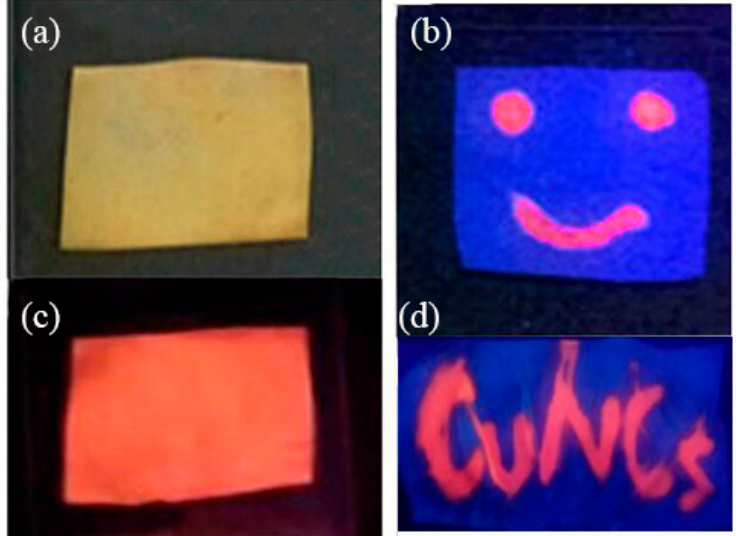
Figure 6. Photos of the monolithic Cu NCs@ESM fabricated by VC reduction in dried form under visible light ( a ) and 365 nm UV light ( c ); Surface fluorescence patterning of smiling face ( b ) and “Cu-N-C-s” letters ( d ) obtained by simply writing the patterning on a piece of ESM with CuSO 4 solution as “ink” followed by NaOH and VC incubation.